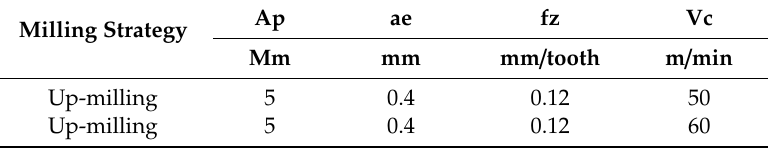
Table 4. Cutting conditions in the cutting speed